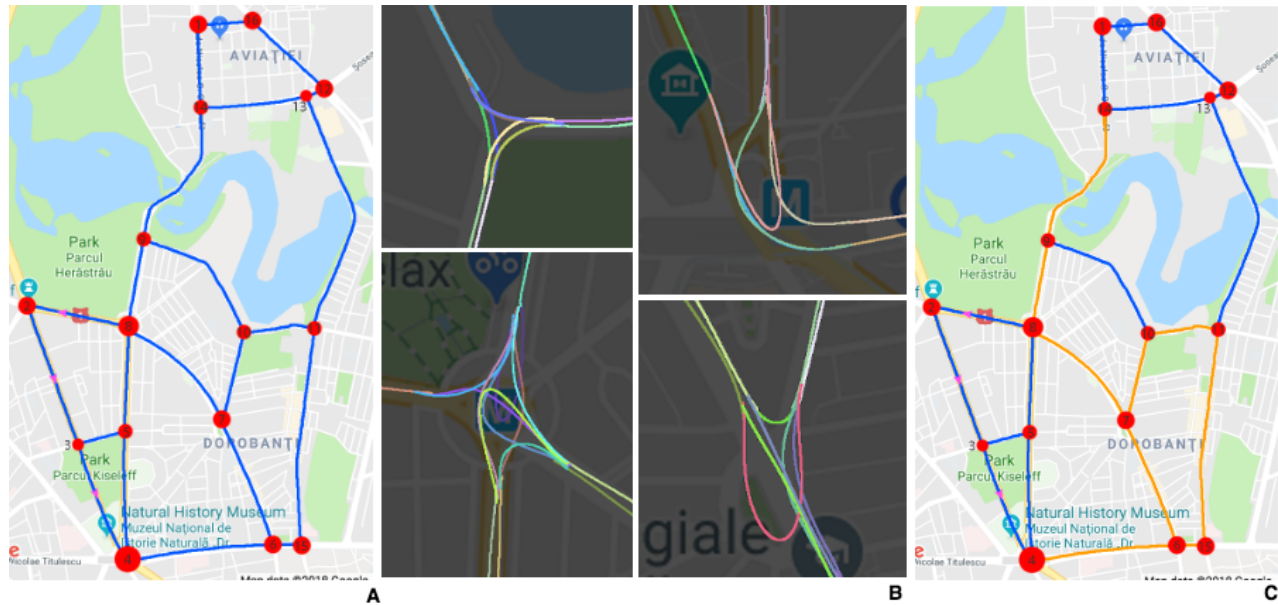
Figure 2. ( A ) The graph structure of the driving map. ( B ) Cropped sections of the analytically obtained map overlapped with the corresponding map regions from Google Maps. ( C ) The sub-part (orange) of the map crossed in the second phase of data